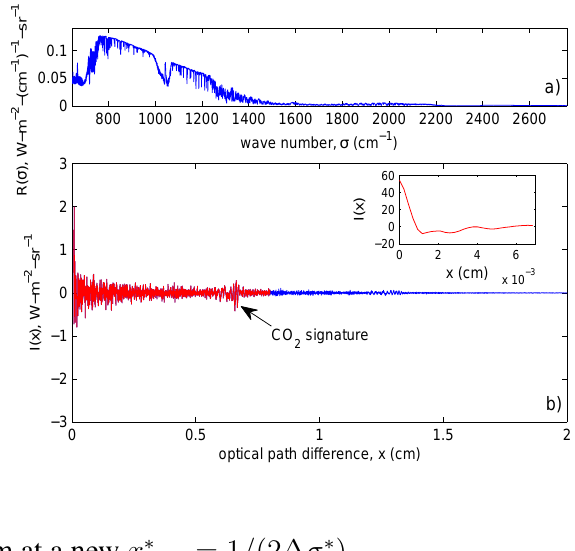
Figure 1. Example of IASI observed spectrum, R ( σ ) , shown in panel (a), and its mathematical Fourier transform, I ( x ) , shown in panel (b). The behaviour of I ( x ) close to x = 0 is shown in the inset. The interferogram interval [0,0.8] cm has been drawn in red in panel